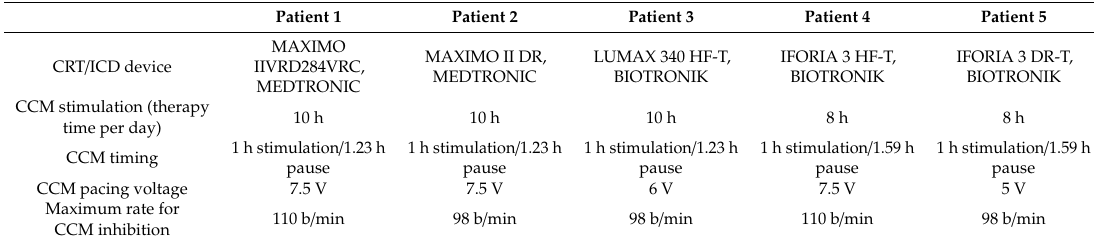
Table 2. Device therapy—Technical data.